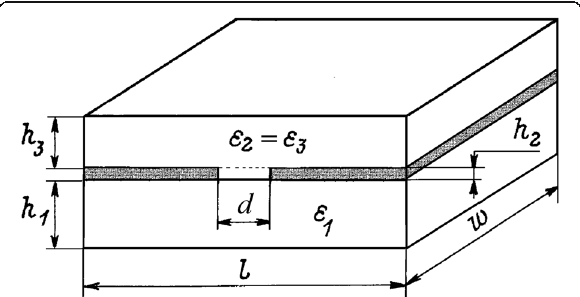
Fig. 5 The scheme of the measured multilayer system consisting of a substrate ( l = 16 mm, w = 24 mm, h 1 = 1 mm), on which electrodes of thickness h 2 = 90 nm were deposited at a distance d = 250 μ m, and the film under investigation was h 3 = 500 nm